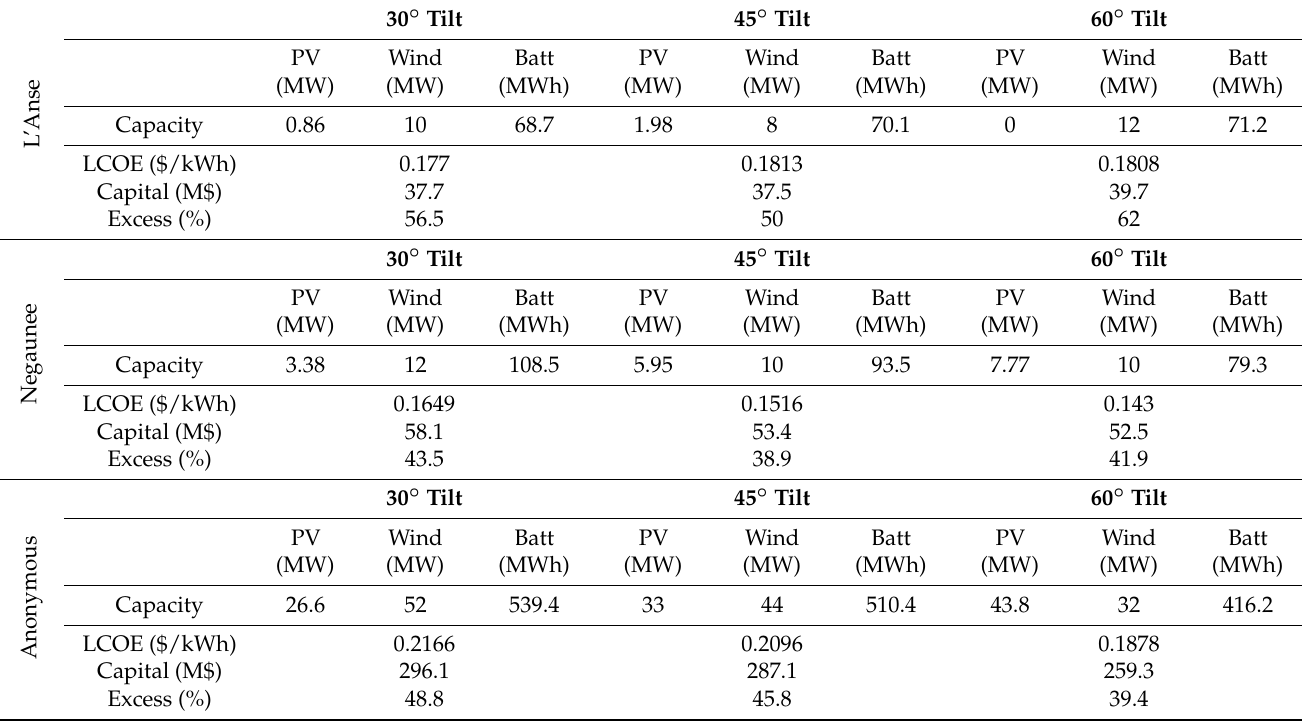
Table 7. LCOE, capacities, and excess generation for each community and PV tilt angle.